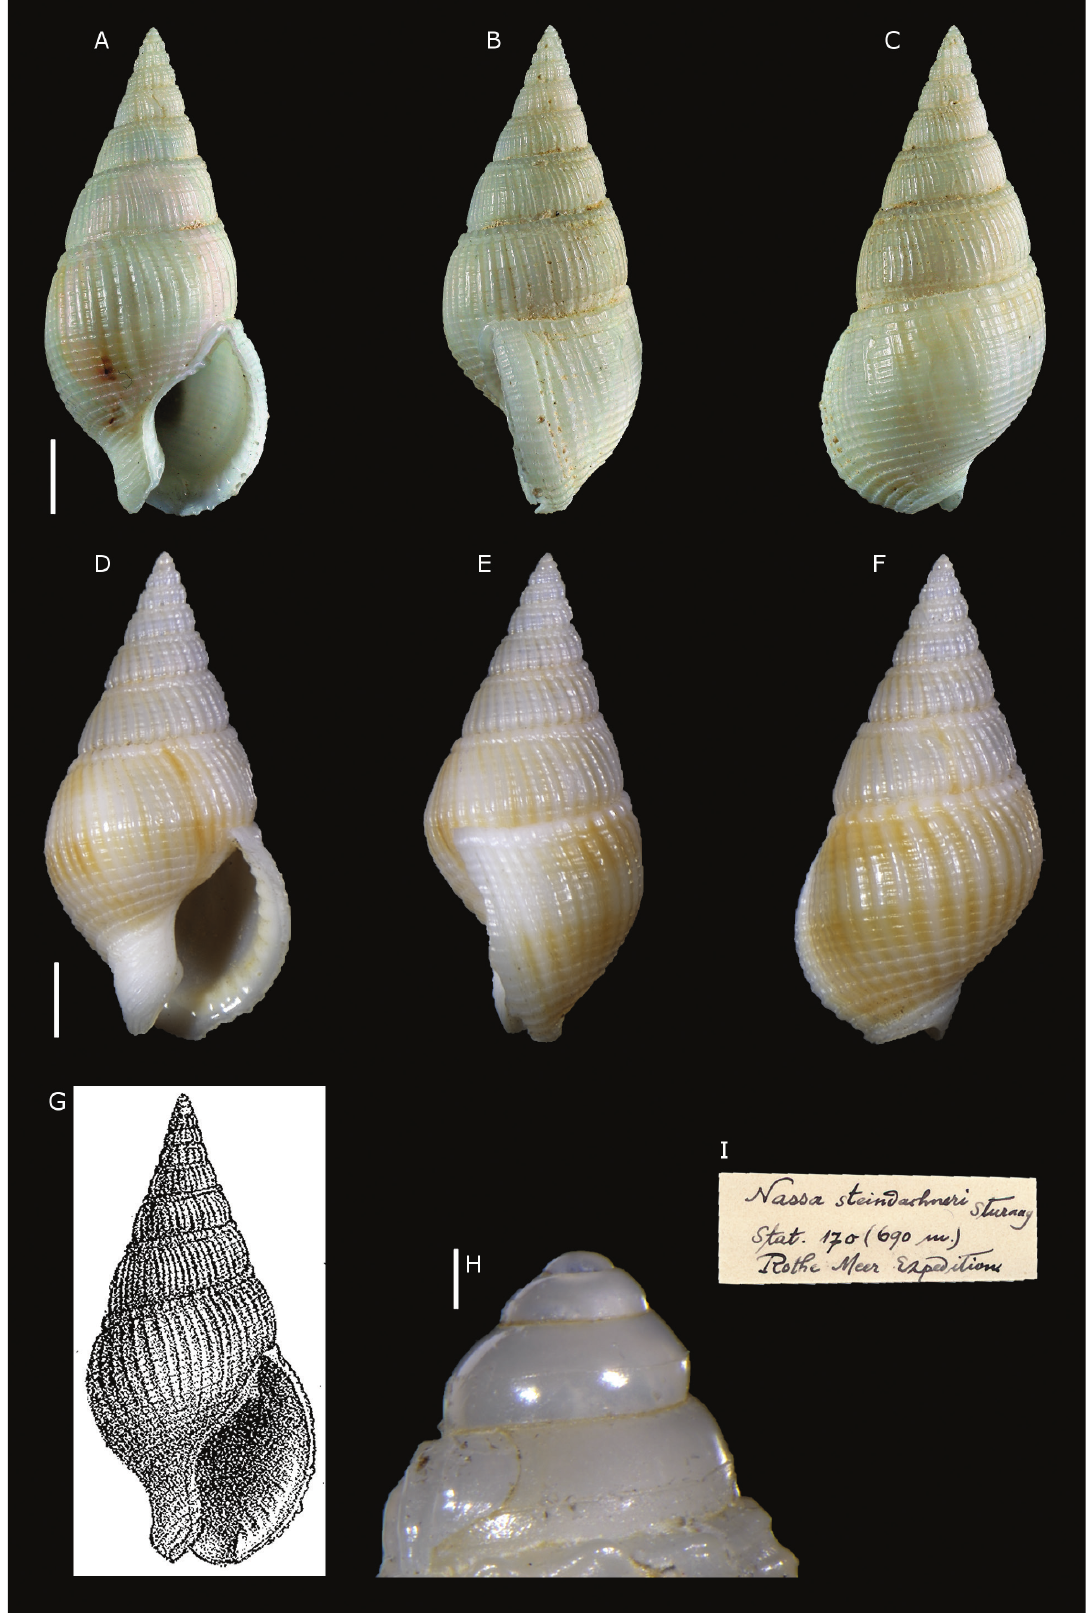
Figure 15 . Nassa steindachneri Sturany, 1900, Station 170 (Noman Island, Saudi Arabia, Red Sea). A–C, H . Syntype, NHMW 84186: front ( A ), right side ( B ), back ( C ), protoconch ( H ). D–F . Syntype, NHMW 84185, Station 135 (Akik Seghir, Eritrea, Red Sea): front ( D ), right side ( E ), back ( F ). G . Original figure by Sturany (1903). I . Original label of syntypes NHMW 84186. Scale bars: A–F : 3 mm, H : 0.2